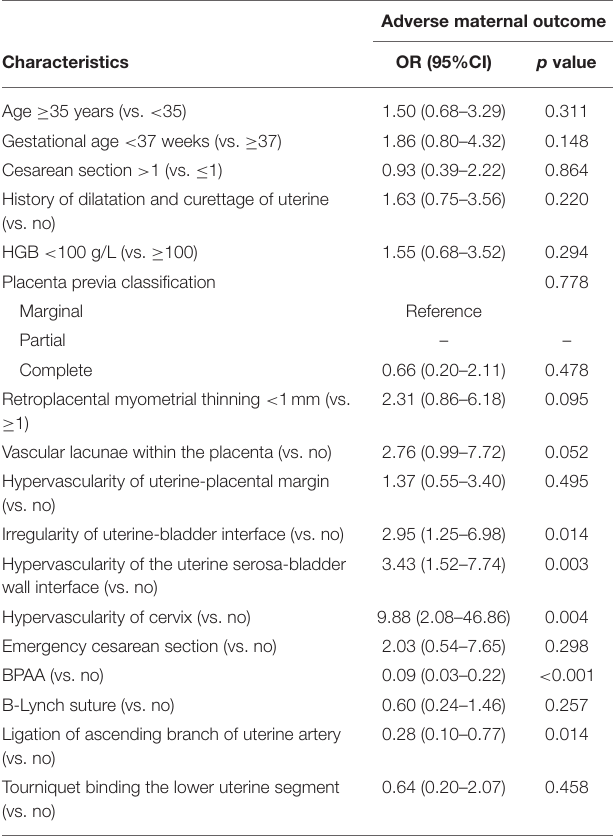
TABLE 3 | Univariate logistic regression analysis of risk factors associated with the adverse maternal outcome in the after propensity score matching cohort. Adverse maternal